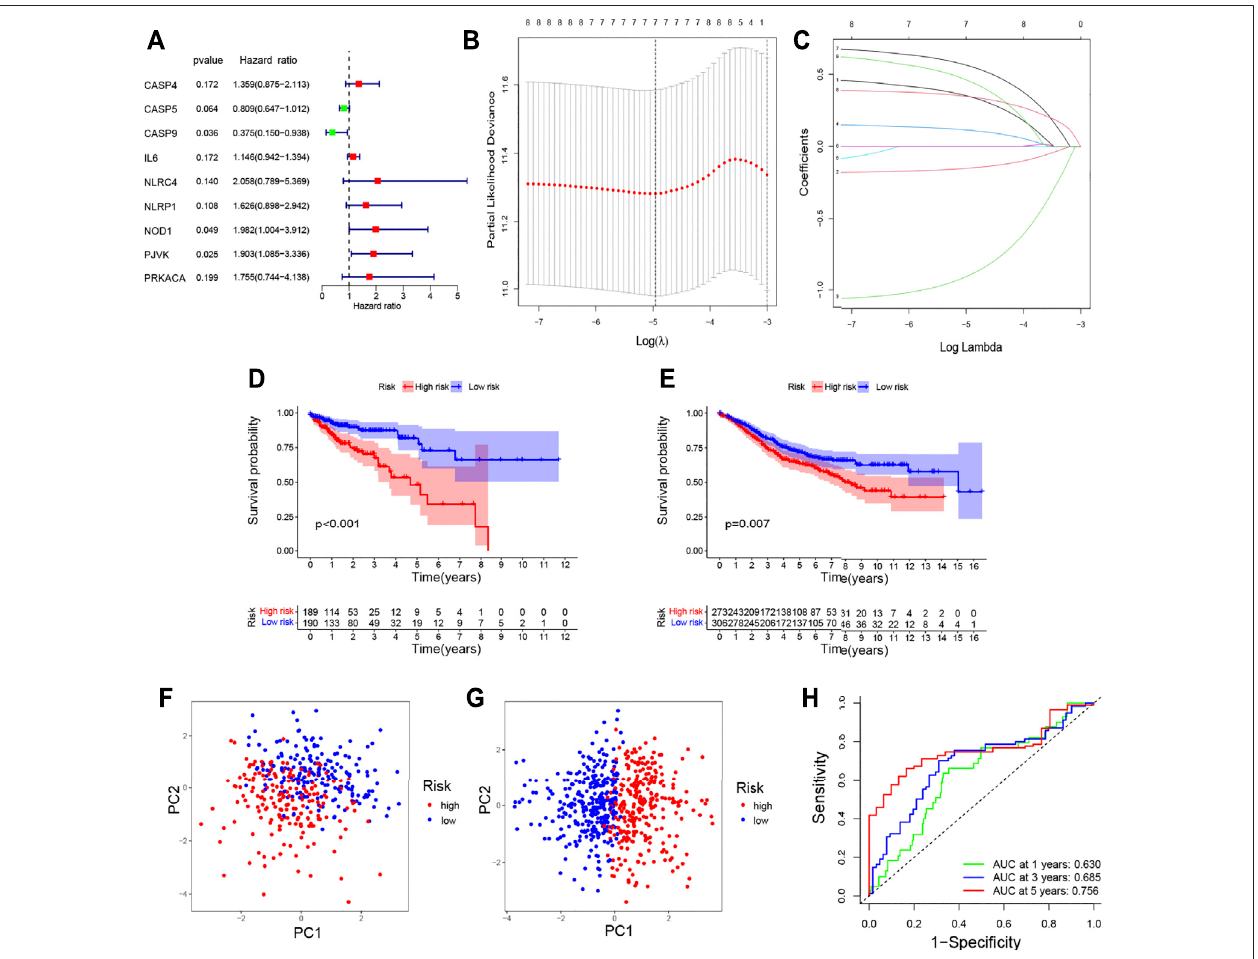
FIGURE 4 | Construction of the prognostic model for COAD. (A) Hazard ratio of univariate Cox analysis for pyroptosis-related DEGs; (B) distribution of LASSO coef fi cientsforsevengenes.Twoverticallinesrepresentlambda.minandlambda. lse; (C) coef fi cientsforsevengenesanalyzedbyLASSO;survivalanalysistoverifythe prognostic model in TCGA (D) and GEO (E) ; PCA plot for COAD based on the risk score in TCGA (F) and GEO (G) ; (H) time-dependent ROC curves for